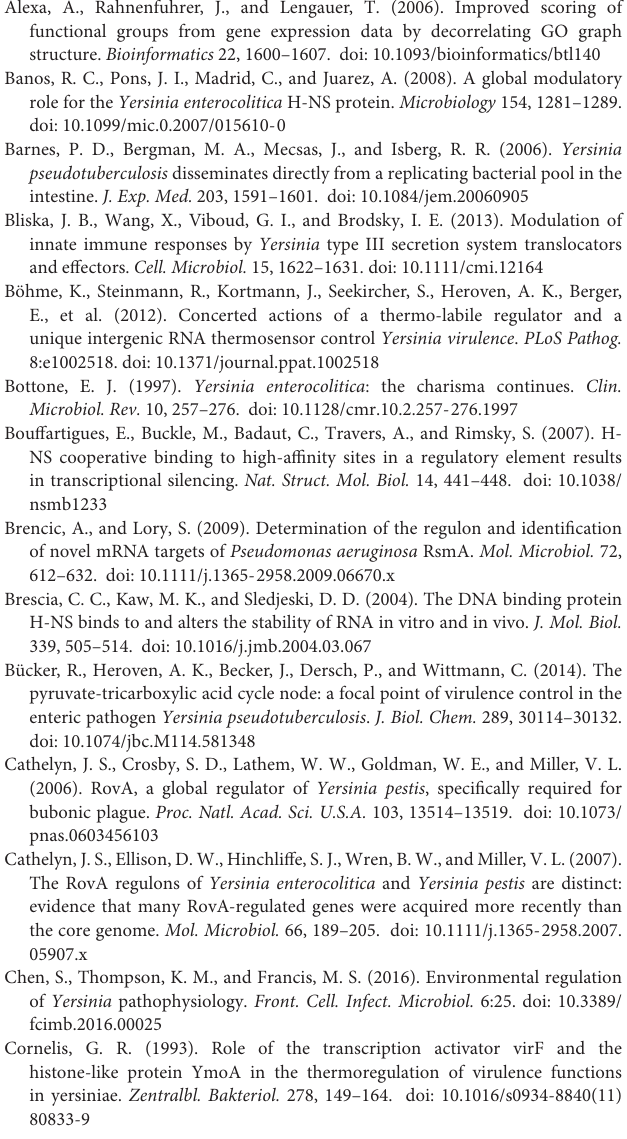
Supplementary Figure 5 | Hfq influence on RovA and RovM levels. Y. pseudotuberculosis strain YPIII and YP80 ( (cid:49) hfq ) carrying the vector pAKH85 (pV) or its hfq + (pAKH115) were grown in LB at 25 ◦ C overnight. Whole-cell extracts from the overnight cultures were prepared and analyzed by Western blotting with polyclonal antibodies directed against RovA or RovM. Unspecifically detected proteins (c) were used as loading control. Supplementary Figure 6 | YmoA influence on Hfq production. Y. pseudotuberculosis strain YPIII and YP50 ( (cid:49) ymoA ) carrying the vector pAKH85 (pV) or its ymoA + derivative (pAKH71) were grown in LB at 25 ◦ C overnight. Whole-cell extracts from the overnight cultures were prepared and analyzed by Western blotting with a polyclonal antibody directed against Hfq. An unspecifically detected protein (c) was used as loading control. Supplementary Figure 7 | Analysis of YmoA and H-NS binding to CsrC and yscW. (A) CsrC RNA ( + 1 to + 150) and a 5S RNA fragment serving as a negative